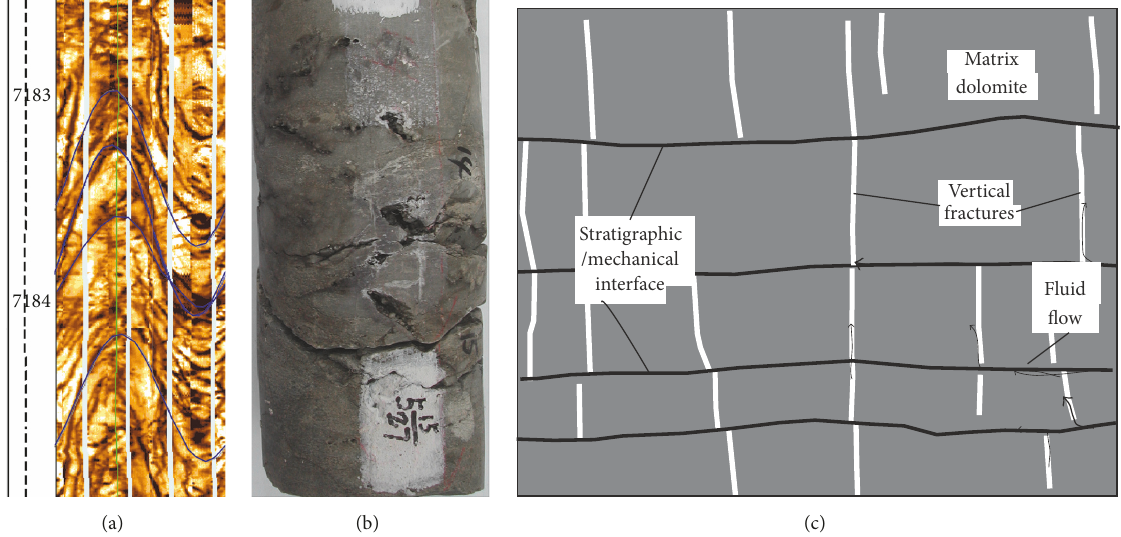
Figure6:(a)Wellboreimageloggingshowsthedevelopmentofshearfracturesonthewall,wellTS1.(b)Boreholecoresshowthedevelopment of low-angle shear fractures at depths of 8407 m, well TS1. Note the vugs developed by dissolving enlargement along the fractures. (c) Stratigraphic controls tensional fracture patterns. Fractures develop within mechanical units and normal to the stratigraphic interfaces. The tensional fractures can serve as an effective network for fluid